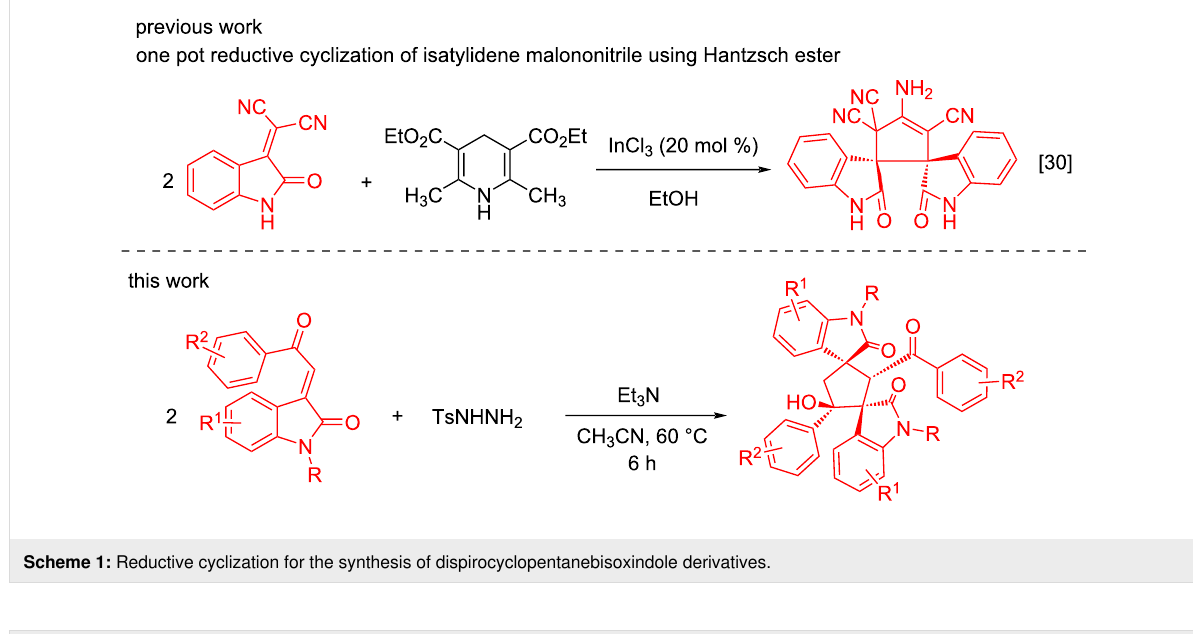
Table 1: Optimization study for the formation of 3a .